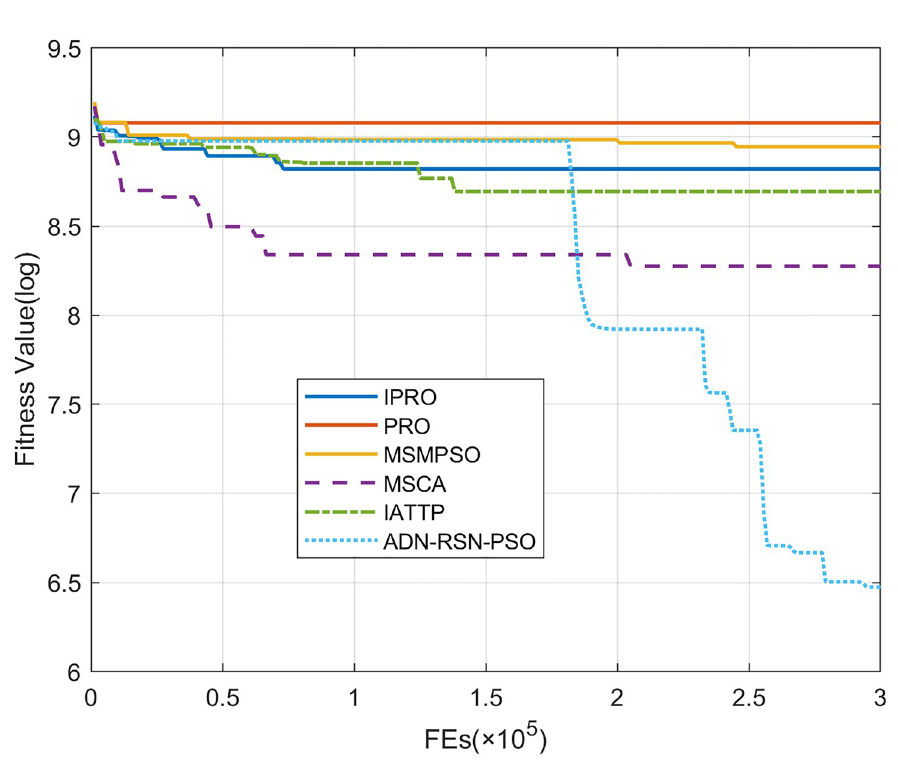
Fig 14. Convergence curves on